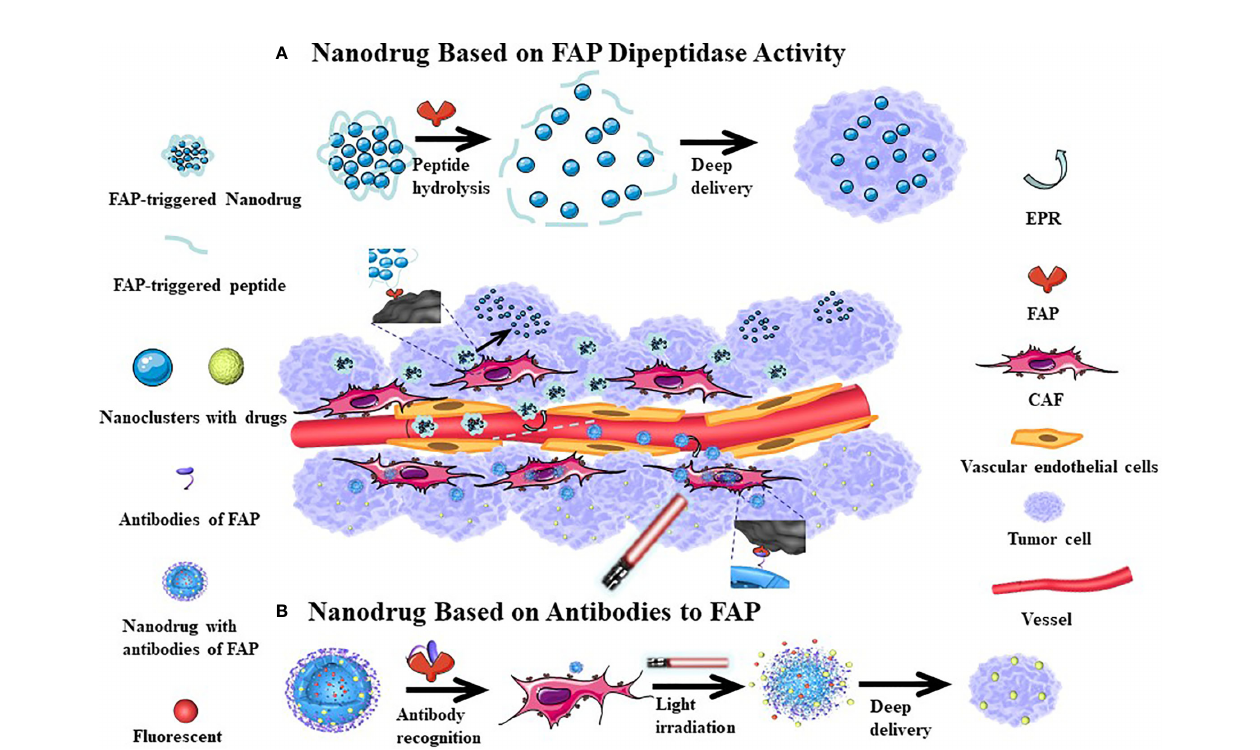
FIGURE 4 | The mechanism of nanodrugs deep delivery in tumor tissues. After the cleavable peptide reacts with FAP, the nanoparticles are broken down into smaller nanoclusters which increases their dispersion (A) . More FAP antibodies can be be more easily attached to the surface of nanomedicine, which can increase the accumulation of drugs in tumor tissues. Following Light irradiation, the nanoparticle splits and the tumor tissue is fl uorescently displayed, where at the same time, a part of CAFs is killed, with the small-sized nanoparticles continuing to have a deep tissue effect (B) . Since the tumor tissue vascular endothelial gap is relatively large, nano-sized drugs can enter the tumor tissue through incomplete vascular endothelium, with relatively few nano-drugs returning from the tumor tissue to achieve the EPR effect. This passive targeting effect causes nanomedicine accumulations in tumor